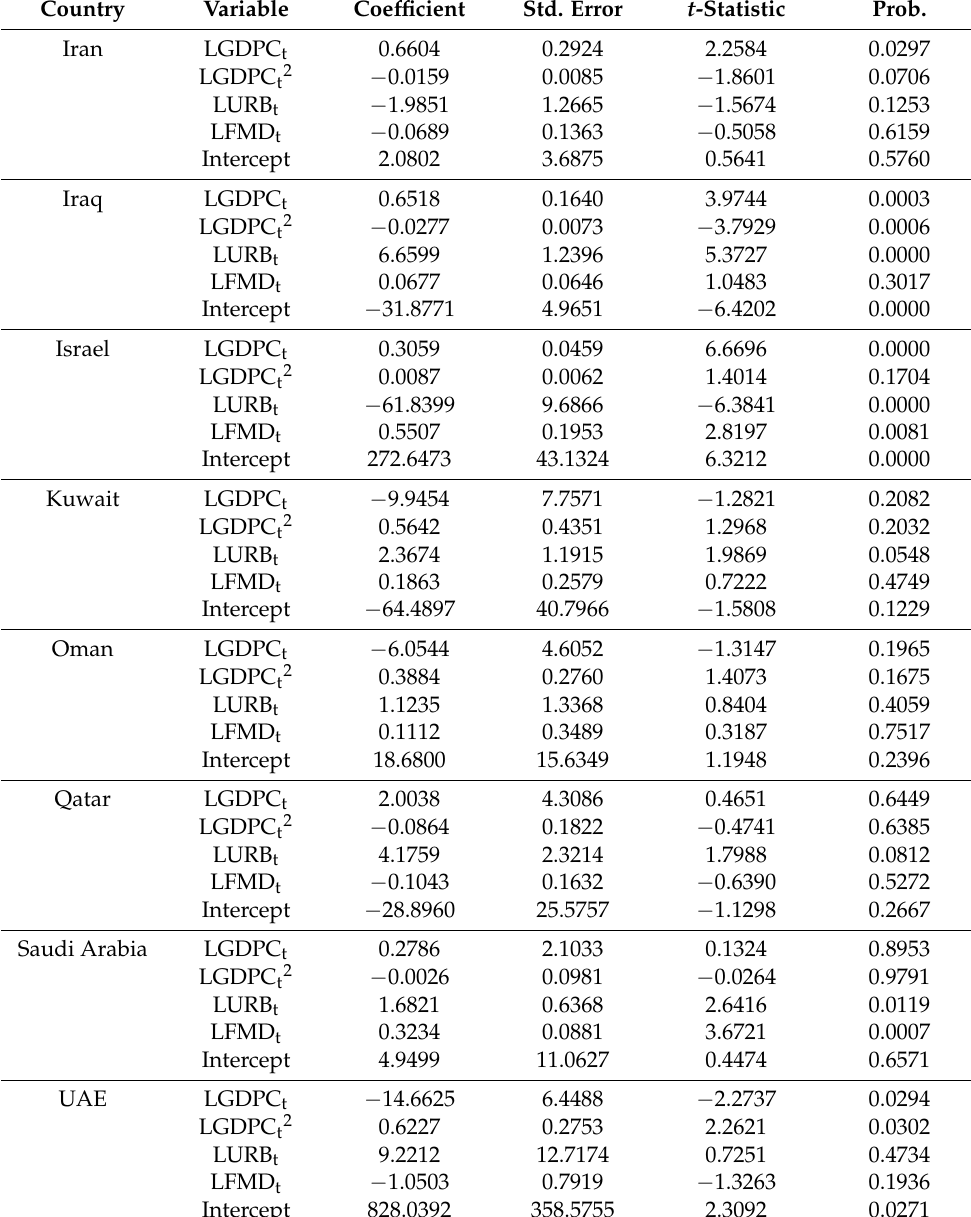
Table 1. Long-run results: LOC t as the dependent